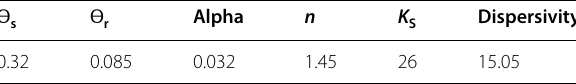
Table 1 Soil physical parameters for model calibration